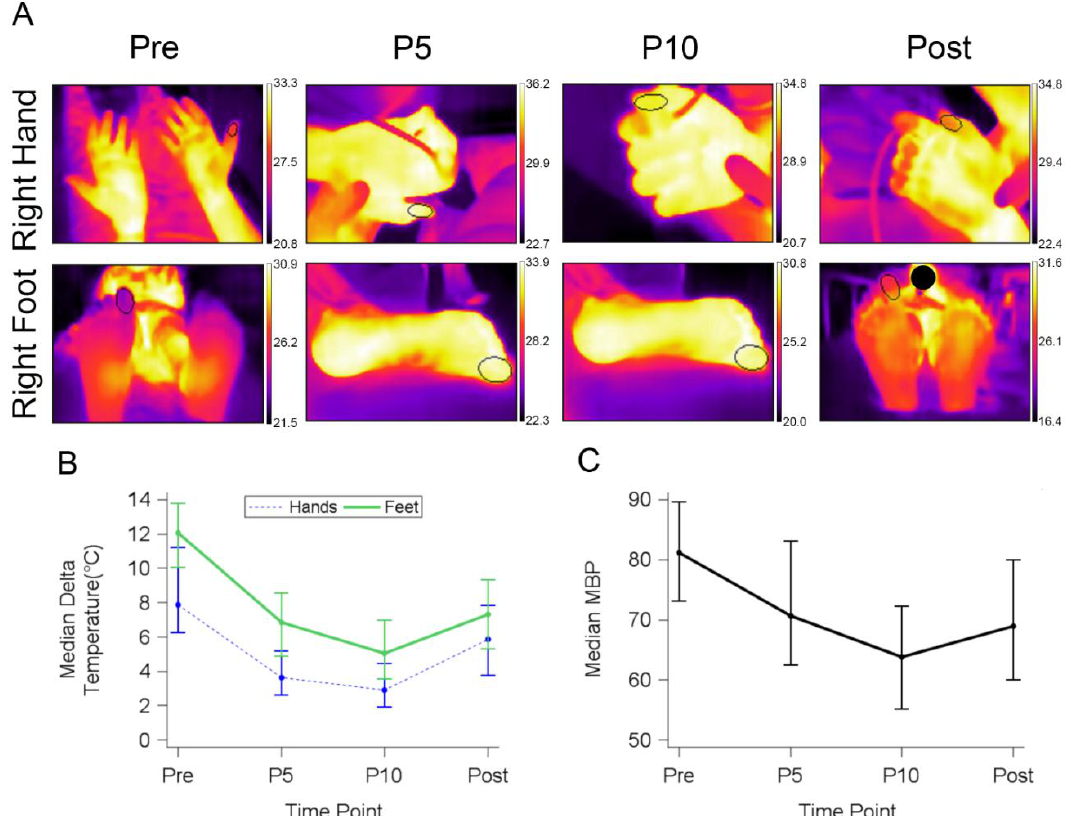
Figure 2. Median delta temperature decreases during propofol sedation. ( A ) Representative serial images before propofol (Pre), at 5 (P5) and 10 (P10) min post-propofol administration, and as the patient awakes (Post). Each row represents one patient over time. Region of interest (ROI; oval) marked during through the pre- and post-sedation time periods. Each image has the corresponding temperature legend in °C. ( B ) Median delta temperature (difference between average ROI reading and initial core) at each time point (Pre, P5, P10, Post). ( C ) Median of all patients’ mean blood pressure (MBP) during propofol sedation and as the patient awakes.